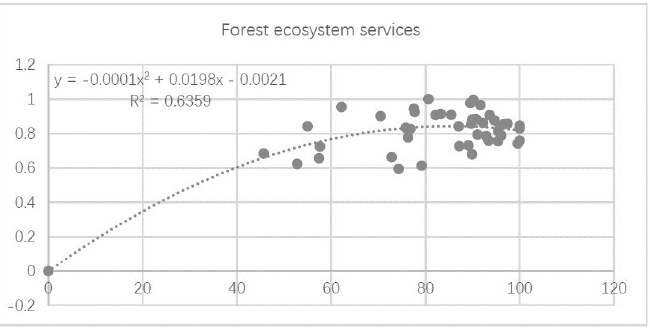
Fig 7. Relationship between forest landscape percentage and forest ecosystem service capacity.